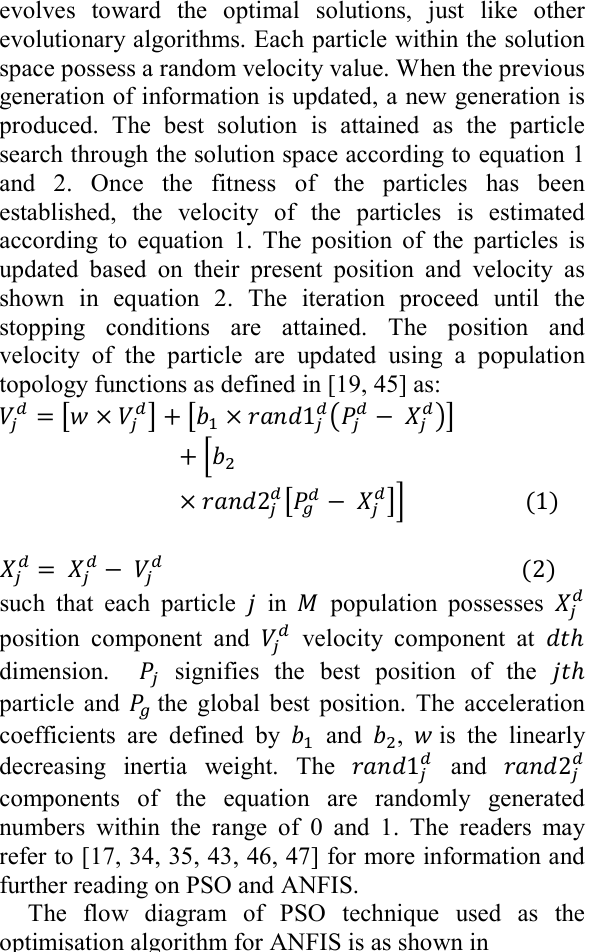
The relationship between the ultimate composition and HHV of MSW can be mathematically expressed